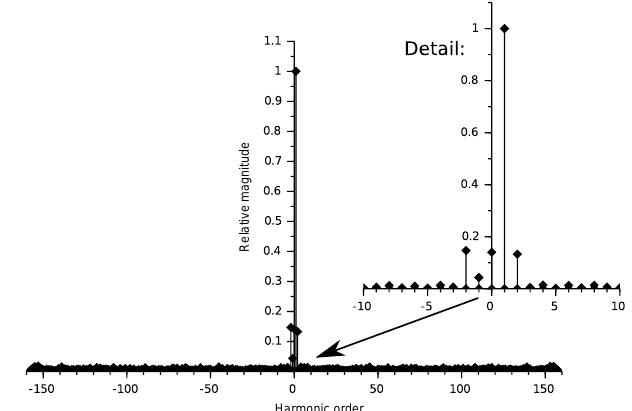
Figure 16. DFT of one period from an orbit in water, k o = 0 . 02, f o = 1 . 5Hz.